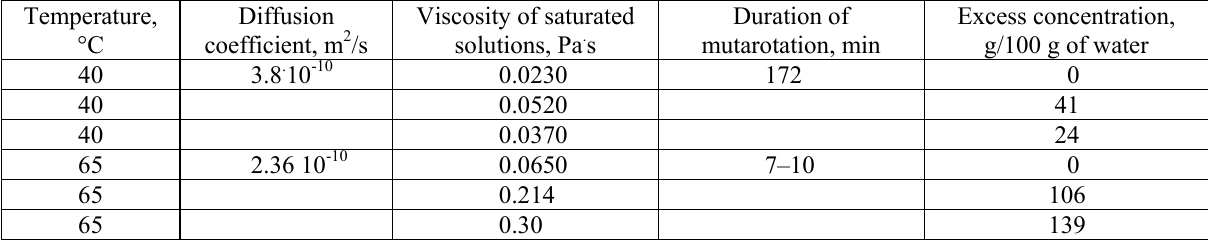
Table 2. Comparative values of the parameters of anhydrous glucose crystallization at a temperature > and < 50°C